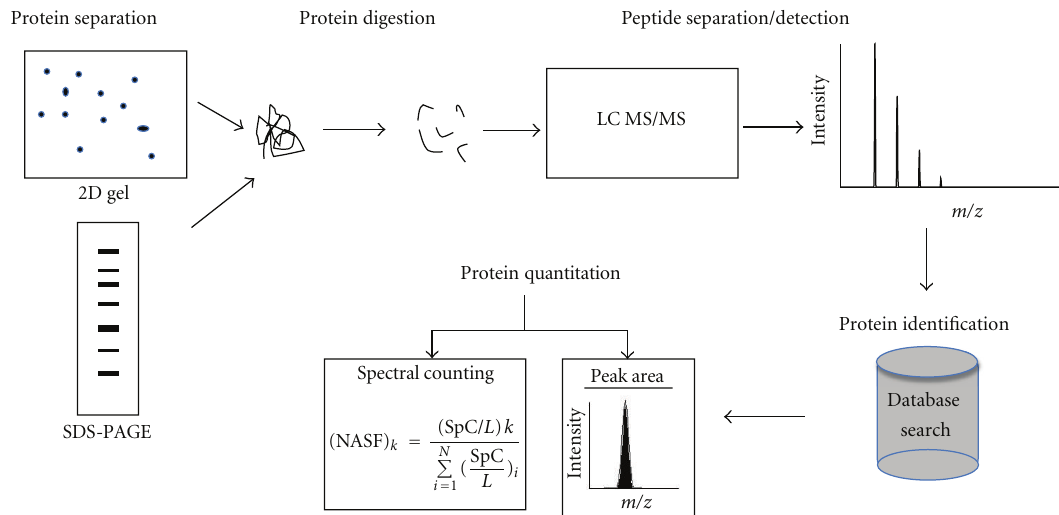
Figure 2: LC MS/MS workflow. Proteins can be separated by 2D or SDS-PAGE prior to mass spectrometry. Proteins are digested into peptides, separated by LC, and identified by mass spectrometry. The mass spectra are searched in a protein database to identify proteins. The proteins are quantified using spectral counting ( k is a given protein, SpC is the spectral count, L is the length of the protein, and N is all proteins identified in the gel lane) or peak areas in label-free proteomics.